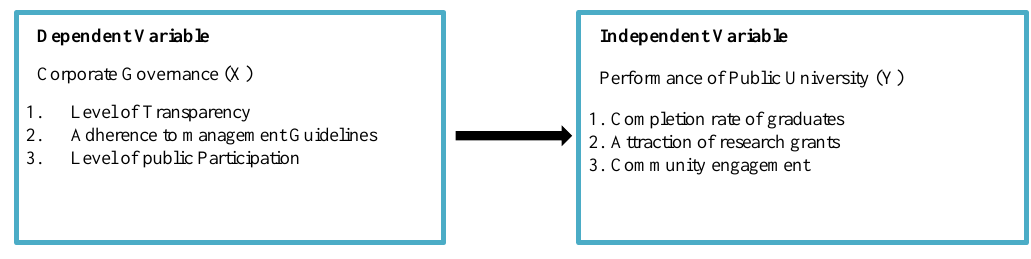
Figure 2: Conceptual Framework; Source: Author,